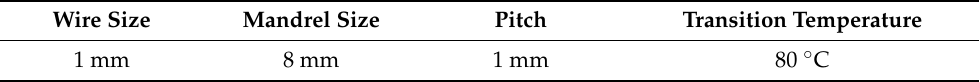
Table 2. Properties of Nitinol shape memory alloy springs obtained from the supplier.